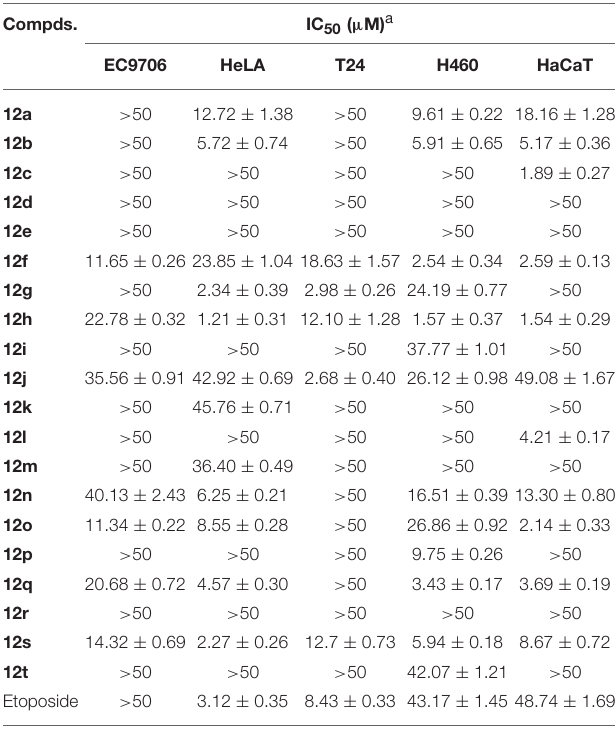
TABLE 1 | In vitro cytotoxicity of compounds 12a–t against five human tumor cell lines with etoposide as control (IC 50 ). Compds.